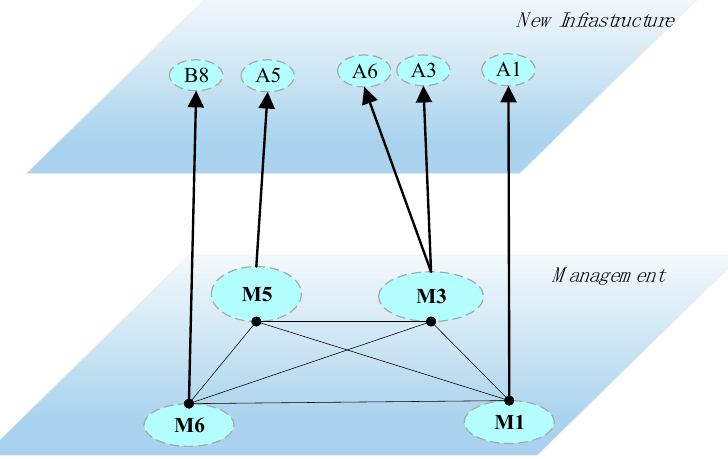
Figure 3. Collaboration between management departments.